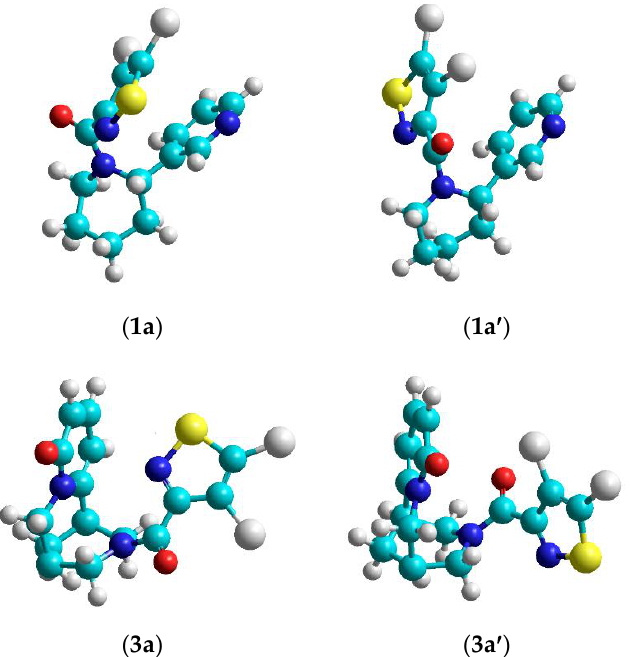
Figure 1. Rotamers of the isothiazole derivatives of anabasine 1a , 1a ’ and cytisine 3a , 3a ’. Table 1. Enthalpy of transition between two energy states of some alkaloid derivatives. Compound E tot1, a.u. E tot2, a.u.